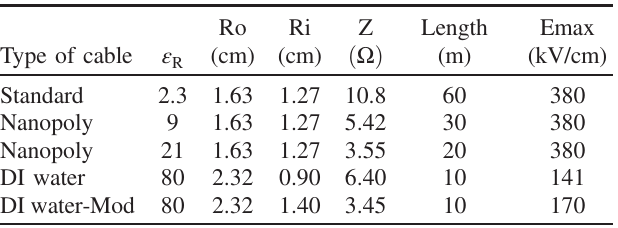
TABLE I. Comparison of cable options to expand the number of bricks while maintaining impedance matching between bricks and cable.